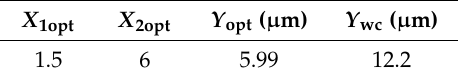
Figure 9. Ŷ 1 and Ŷ 2 response surfaces. Figure 9. ˆ Y 1 and ˆ Y 2 response surfaces. Table 5. Results of the DOE